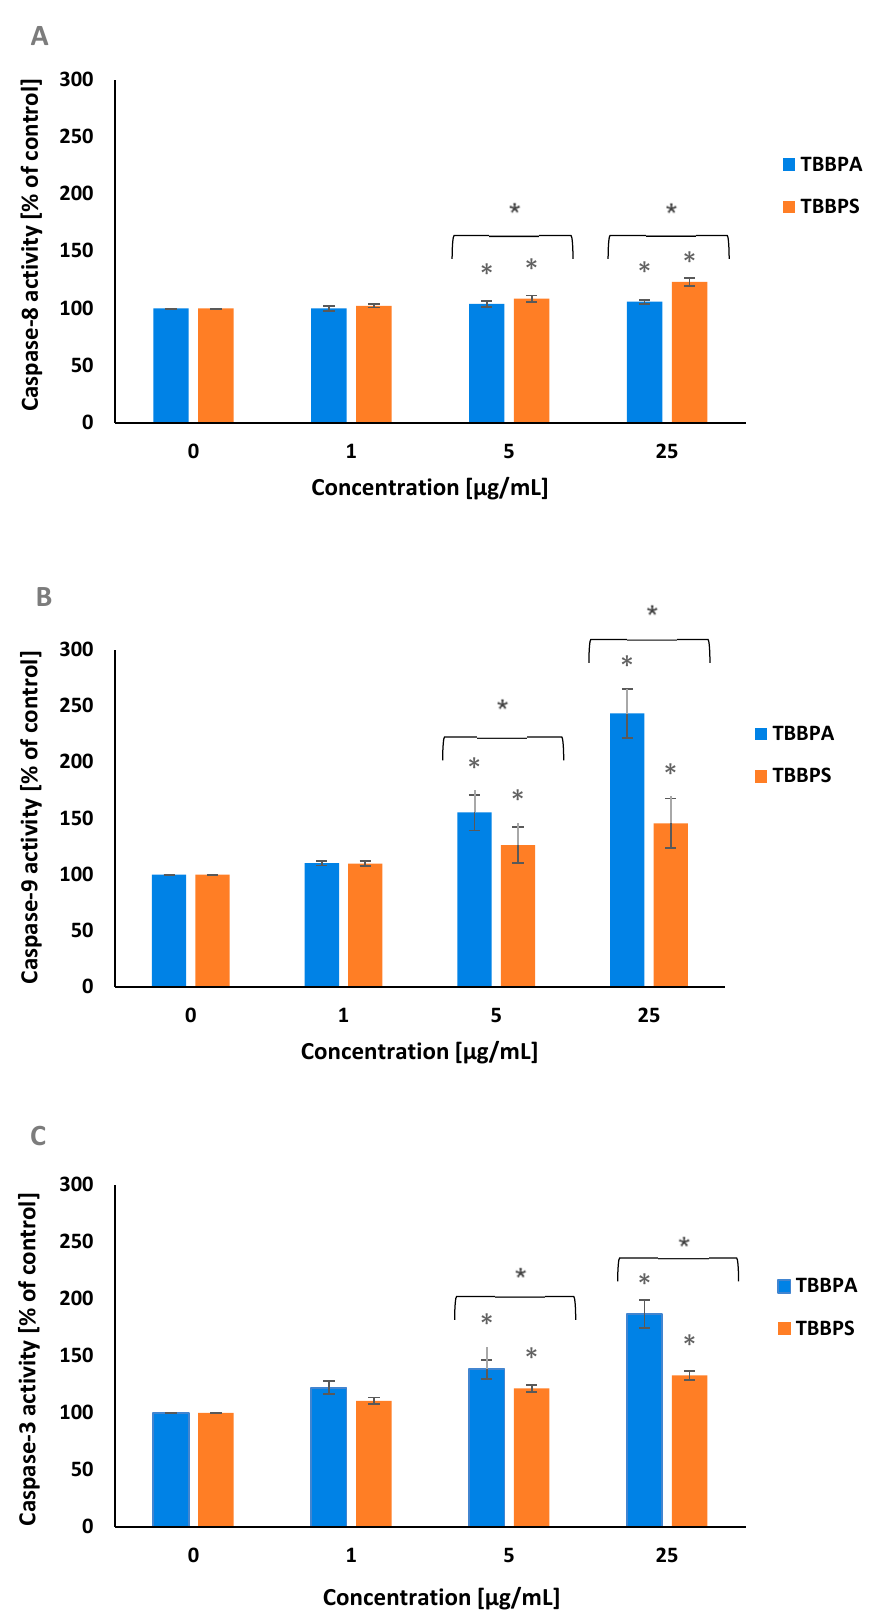
Figure 4. Alterations in caspase-8 ( A ), caspase-9 ( B ) and caspase-3 ( C ) activity in PBMCs treated with TBBPA and TBBPS in the range from 1 to 25 µg/mL (n = 4) for 24 h. Statistically different from negative control at * p < 0.05. Statistical analysis was conducted using one-way ANOVA and a posteriori Tukey